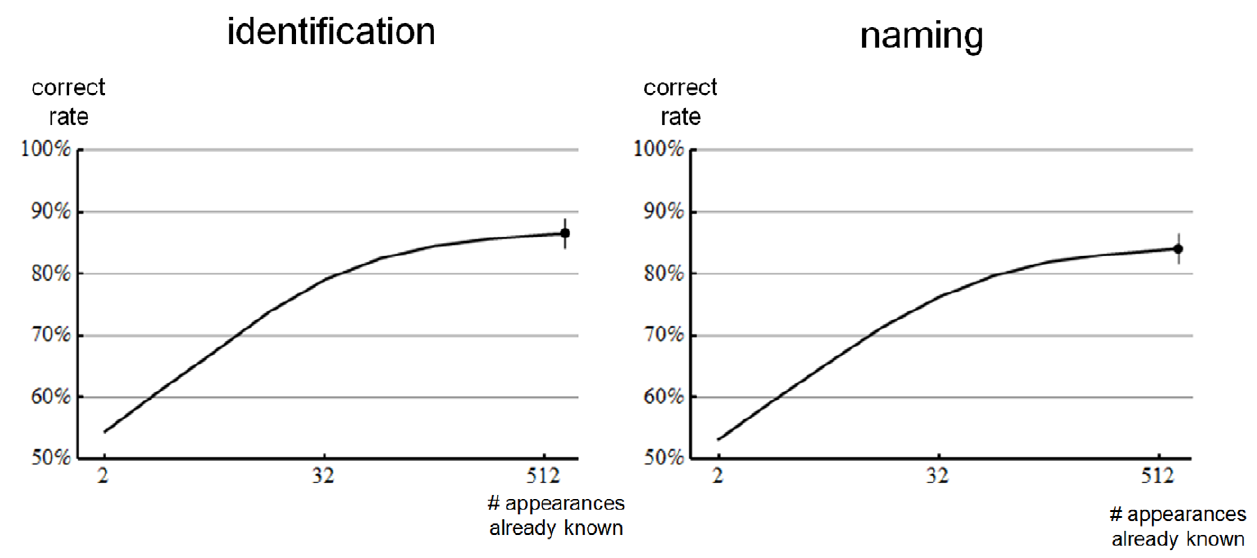
Figure 6. Identification and naming results. Plots show correct rates versus number of already-known appearances for the identification and naming tasks illustrated in figure 3. The baseline chance performance rate for these tasks is 50%. The response to each trial was choosen using the MIRRORING strategy illustrated in figure 5, with the word similarity ( S W ) being implemented using Distributional Similarity ( DST ) and the appearance similarity ( S A ) being implemented using Colour and Textons. At the highest point of the curves an error bar indicates the 95% confidence interval for the maximum performance obtained. Other confidence intervals are not shown but are no larger in magnitude.